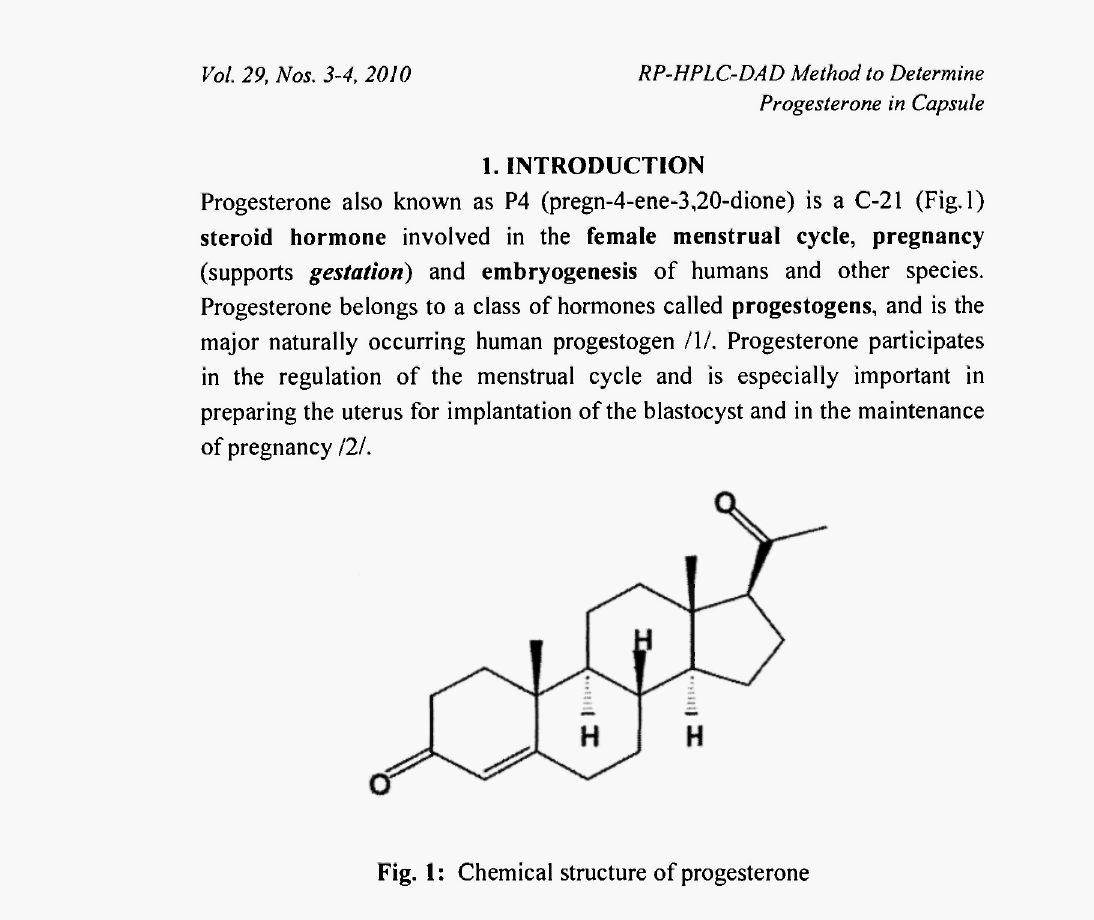
Fig. 1 : Chemical structure of